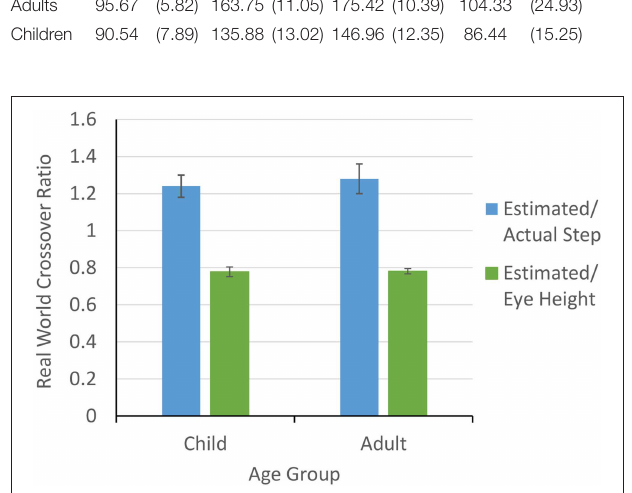
FIGURE 6 | Ratios for stepping over a gap when scaled to actual step and eye height for both children and adults in Experiment 2.